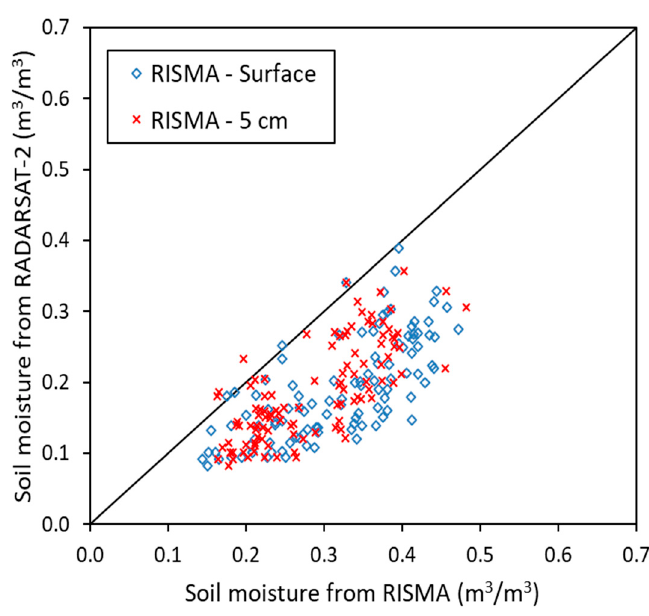
Figure 6. Comparison between retrieved soil moisture values from RADARSAT-2 and RISMA in-situ measurements at surface and at 5 cm soil depth.